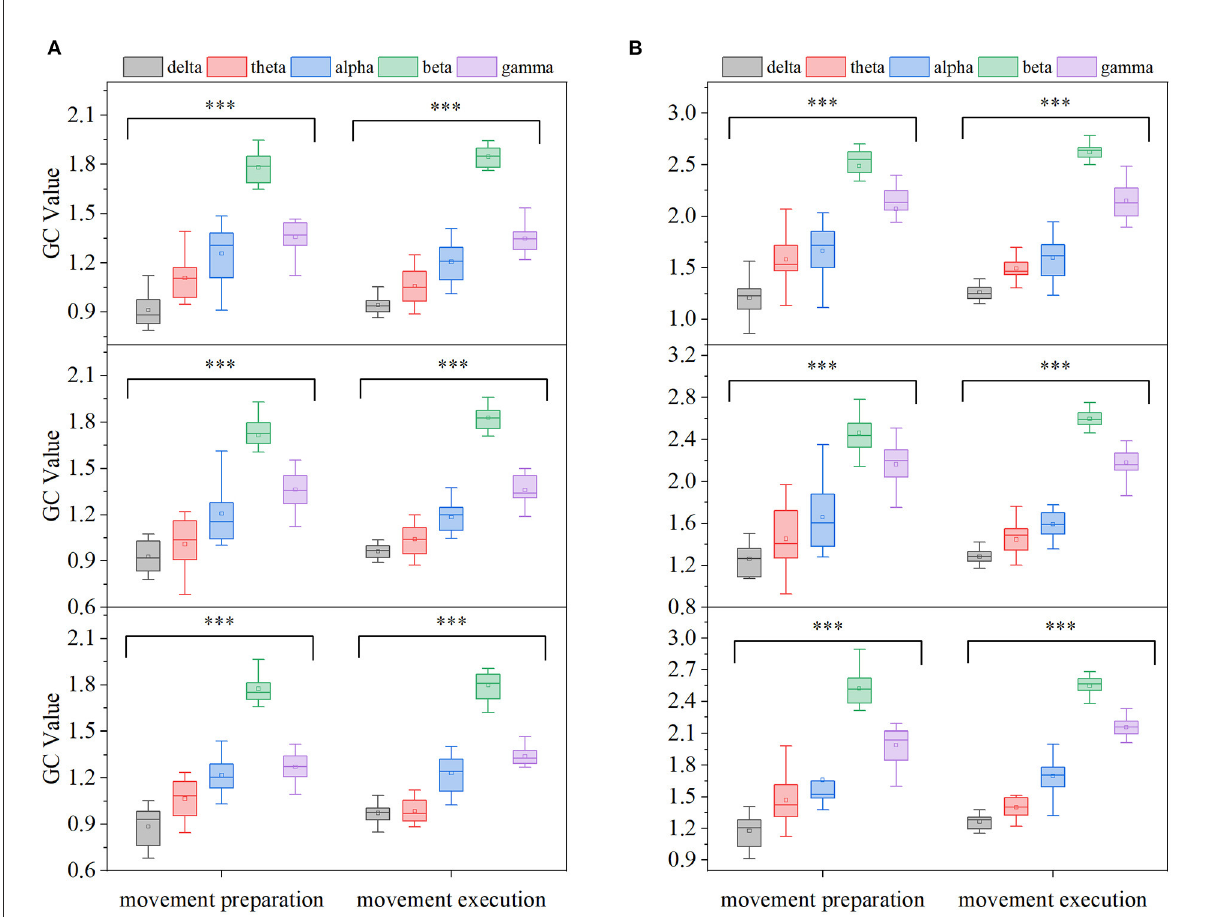
FIGURE6 Comparison of GC averages under different frequency bands (from top to bottom, card, ball, and cup hand-grasping movement, respectively, *** p < 0.01). (A) EMG → EEG, (B) EEG → EMG.